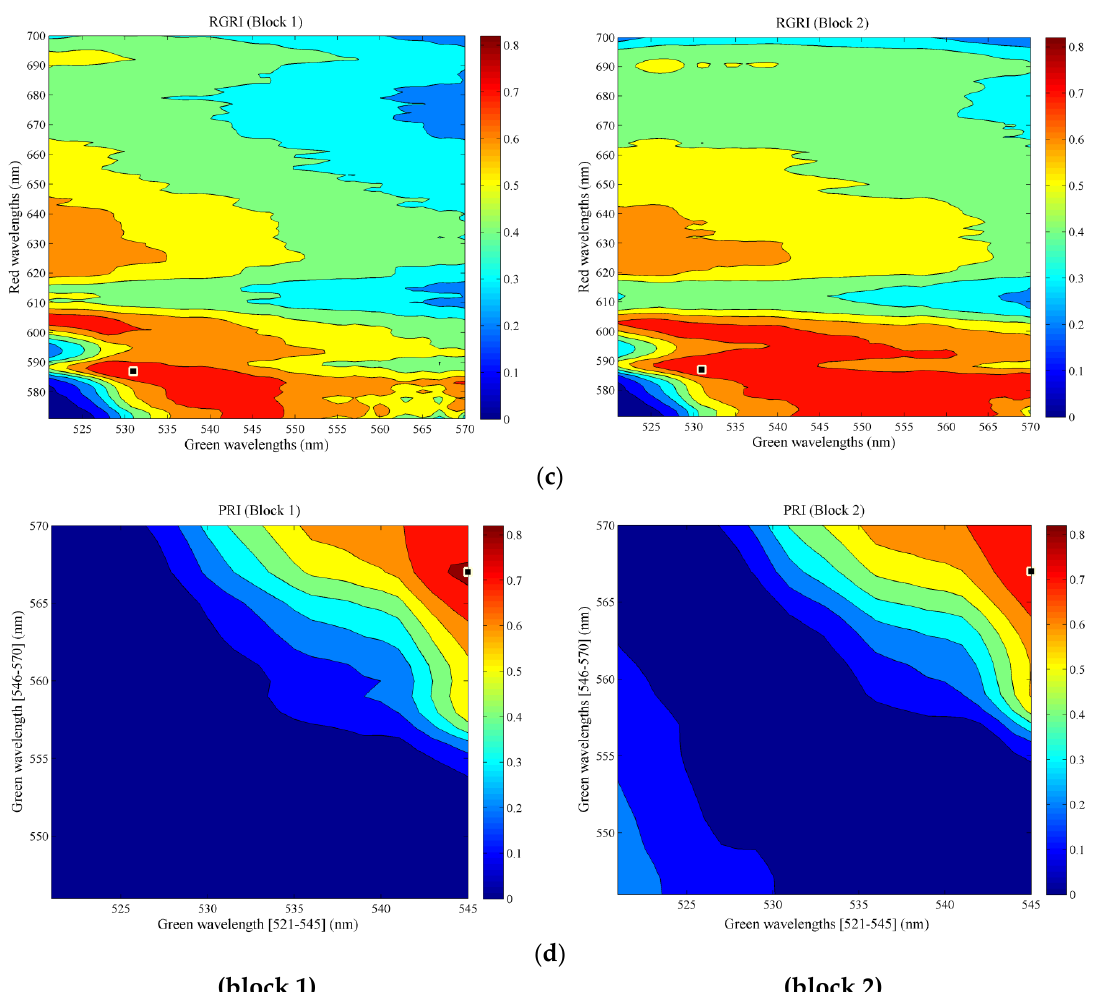
Figure 3. Contour maps of the squared Pearson correlation coefficient (r 2 ) between the measured Ψ pd and the two-bands vegetation indices GI ( a ); NDGI ( b ); RGRI ( c ); and PRI ( d ) obtained with the combination of all individual wavelengths for the block 1 ( left ) and block 2 ( right ). Black dots refer to the best combination of individual bands (1 nm wavelengths) per vegetation